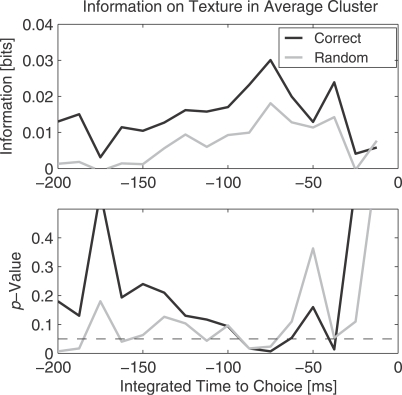
Texture Information Carried by Firing RateUpper panel: information about the two stimuli transmitted by firing rate, averaged across clusters, using backwards-growing windows as in Figure 8A, for correct only and random trials. Lower panel: significance of the information on correct trials being greater than chance (black trace) and significance of the information on correct trials being greater than on random trials (gray trace); p < 0.05 for time windows from −75 to 0 ms. The dashed line shows the 5% limit.